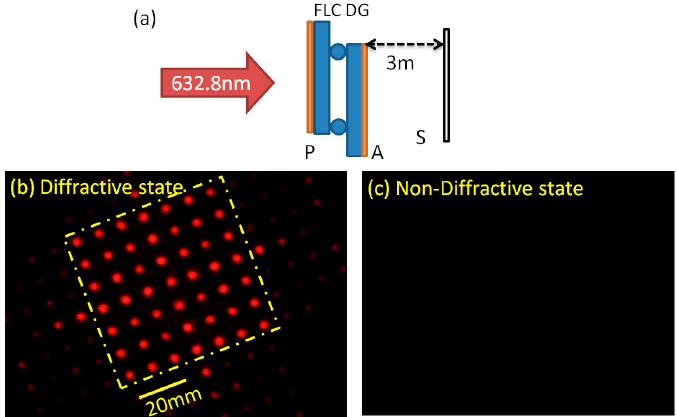
Figure 3. ( a ) Optical setup for measure the ESH-FLC DG diffraction; ( b ) Diffractive pattern for the diffractive state; ( c ) Diffractive pattern for the non-diffractive